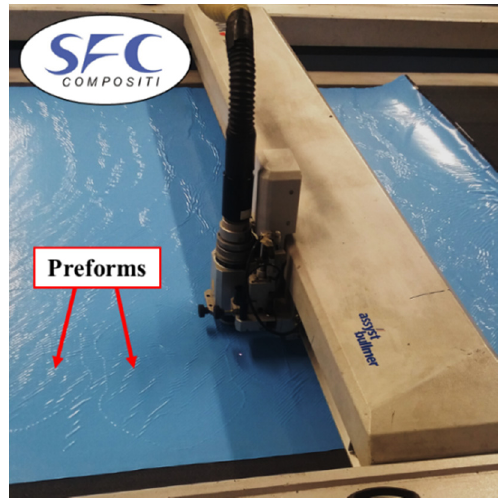
Figure 10. Cutting of Double Dome preforms.